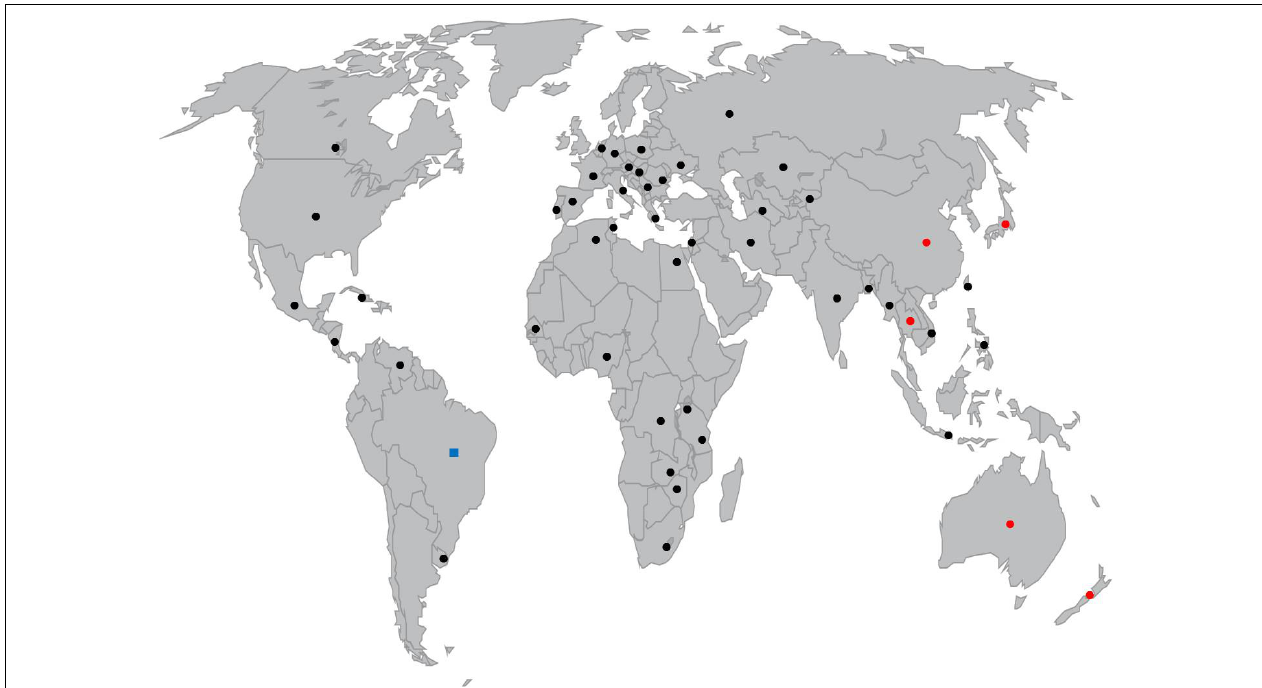
FIGURE 1 | World map representing countries where C. raciborskii presence was reported with cylindrospermopsin or analogs ( (cid:15) ) and PSP toxins ( (cid:4) ) producing